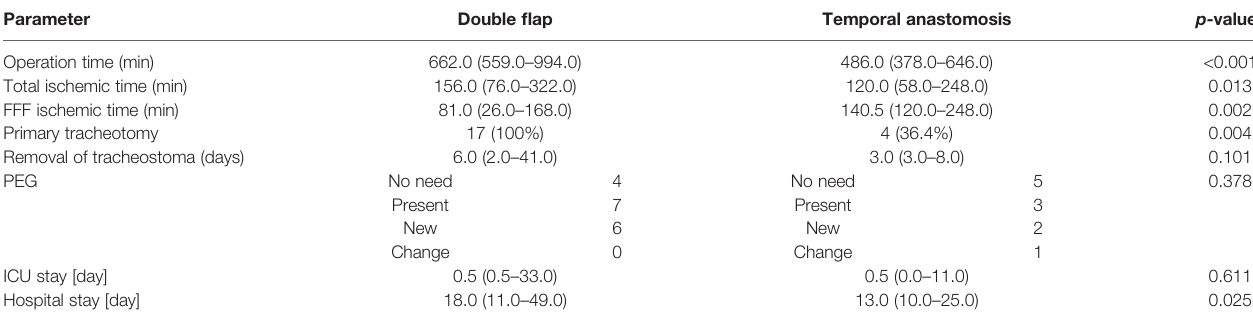
TABLE 2 | Speci fi cations of the operation and hospital stay [incidence or median (range)] of both groups [double fl ap ( n = 17) and temporal anastomosis ( n = 11)]. Parameter Double fl ap Temporal anastomosis p -value a Operation time (min)